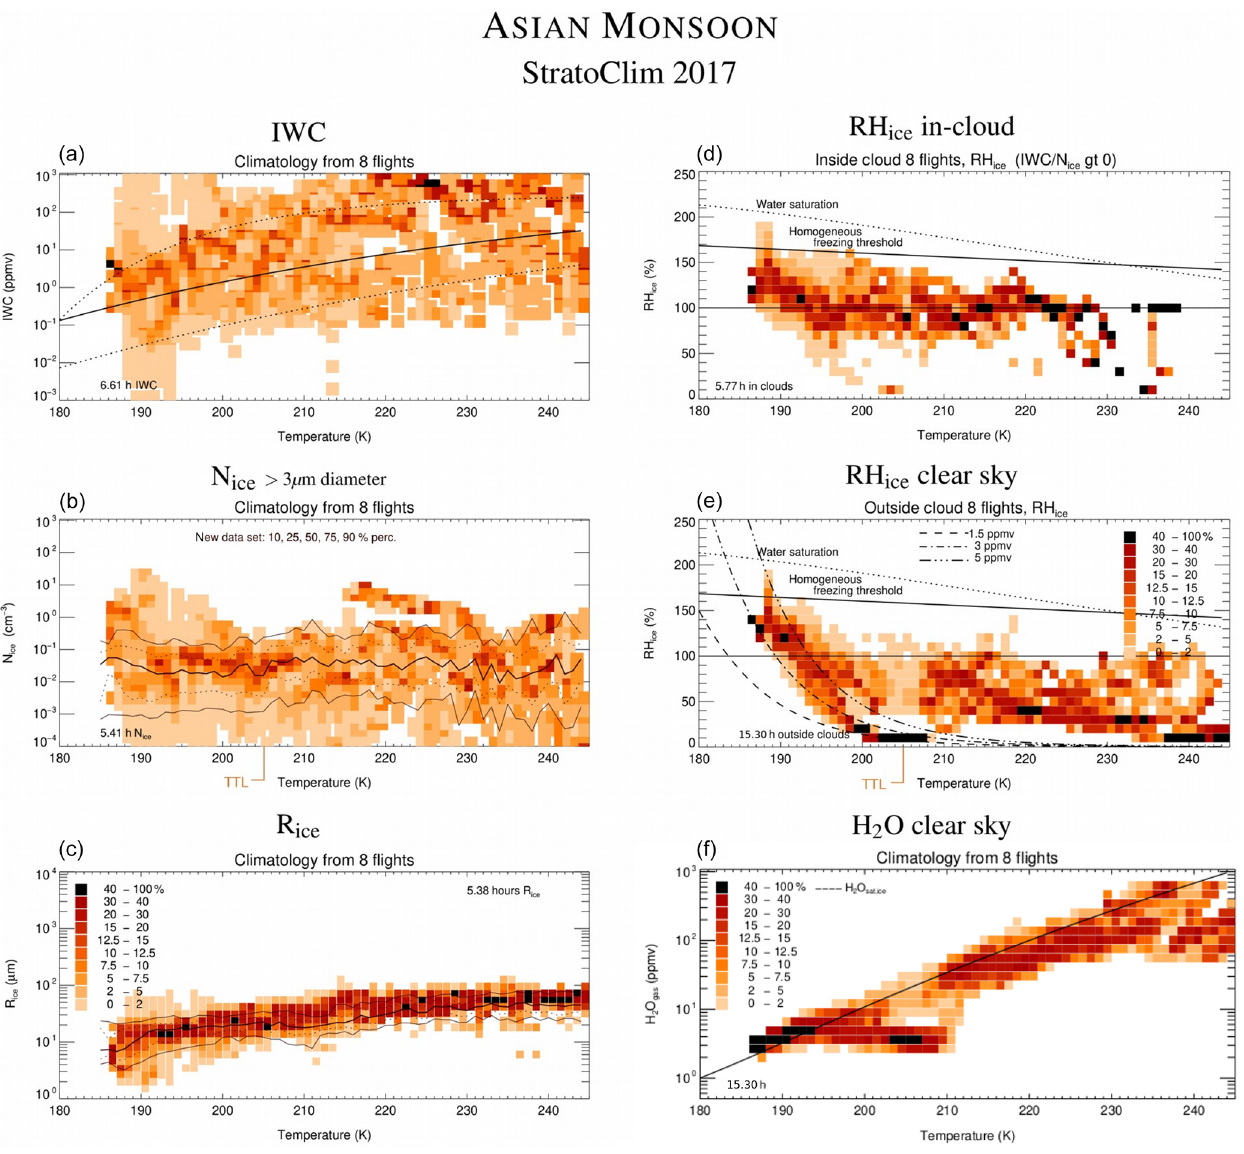
Figure 10. Same as Fig. 7, but for the field campaign StratoClim 2017 above the Asian